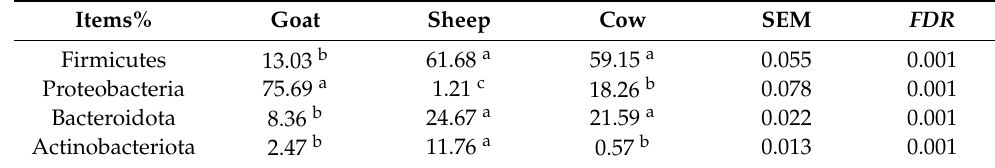
Table 5. Comparison of the bacterial composition between goat, sheep, and cow at the phylum level. Items% Goat Sheep Cow SEM FDR Firmicutes